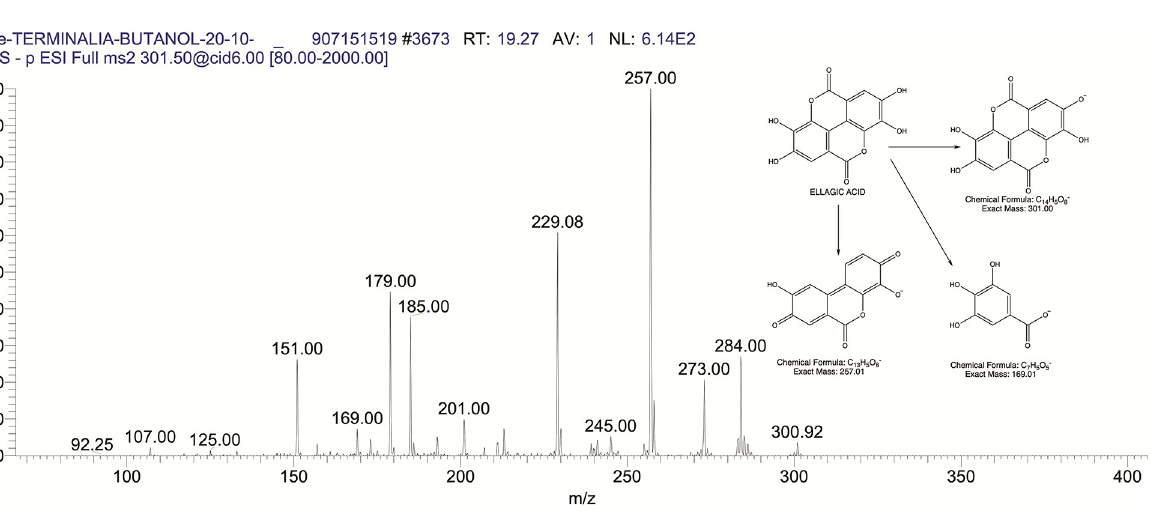
Fig 14. The mass spectrum of ellagic acid and its fragmentation